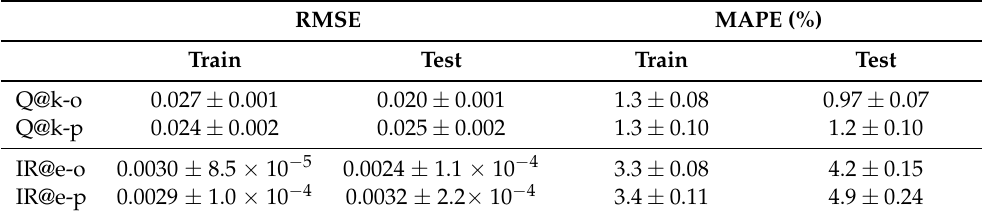
Table 3. Performance of model to predict future capacity and IR, when current capacity/IR is known. RMSE MAPE (%) Train Test Train